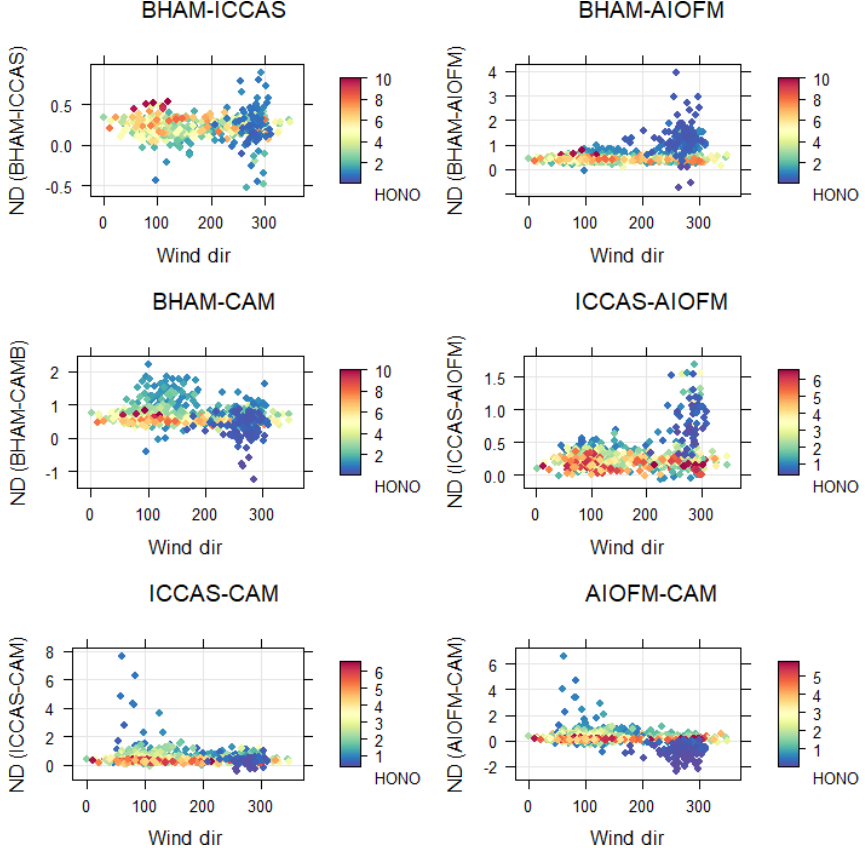
Figure 3. Normalized differences (ND) for each instrument pair as a function of wind direction coloured by measured HONO concentration for the winter intercomparison. Note the different scales for the y axes and HONO abundance colour key.